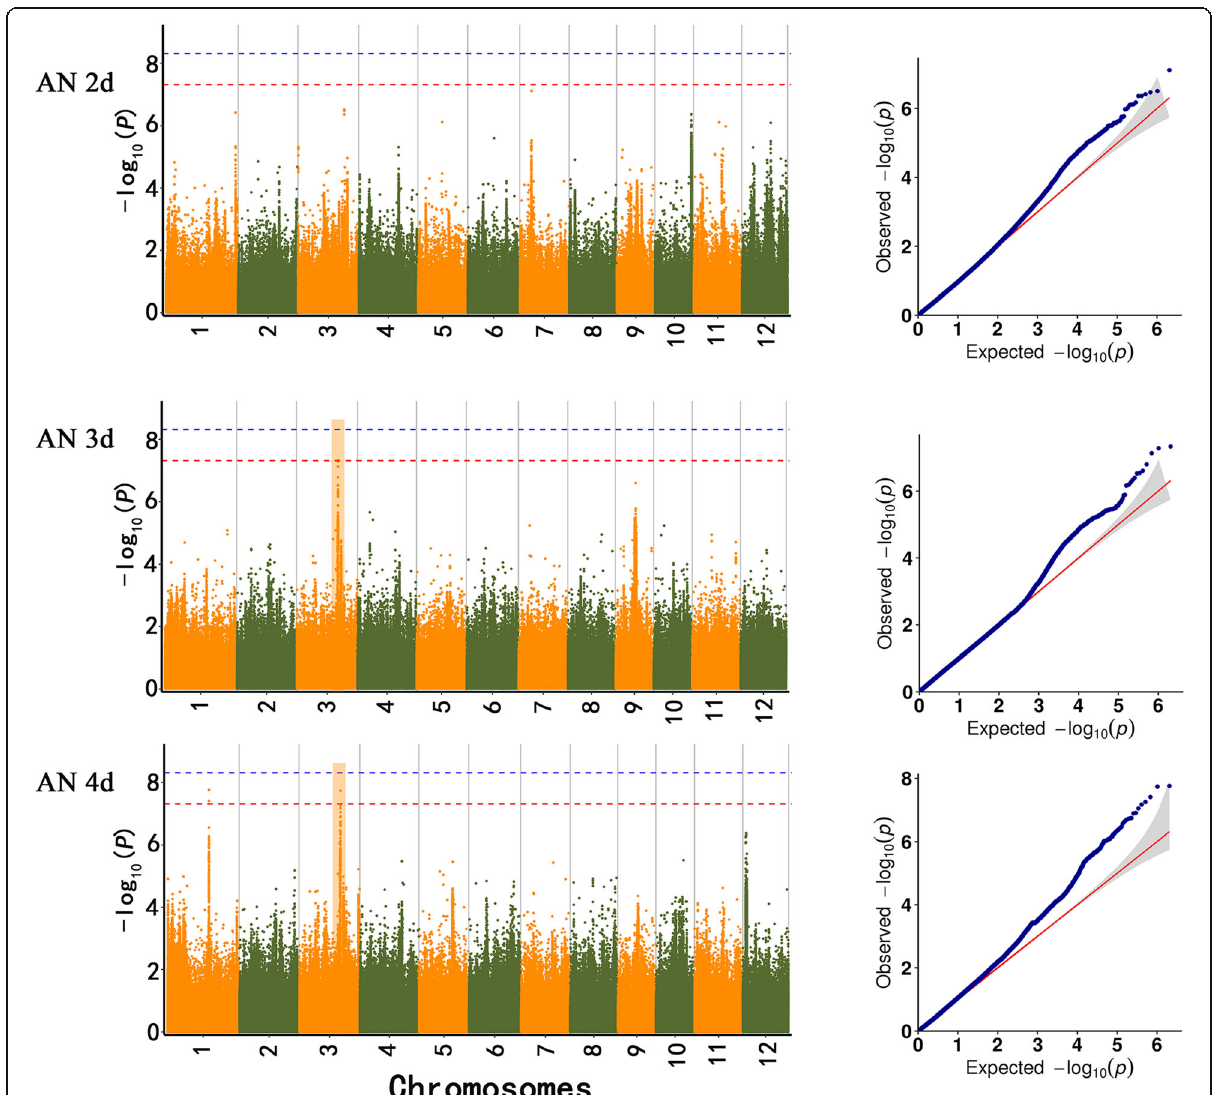
Fig. 4 Manhattan map of SNPs associated with coleoptile length at different time points under anaerobic germination. The red horizontal line indicates the significance threshold of multiple comparisons ( P < 0.1). The genomic regions detected in our GWAS and previous parental mapping studies were labeled as published QTLs with blue text. Orange blocks represented two co-localized genomic regions under anoxic pressure for different lengths of time in our GWAS